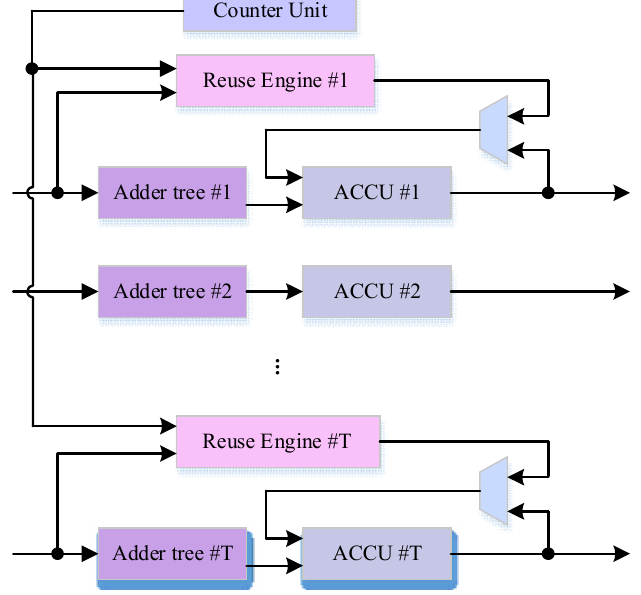
Figure 5. The architecture of Reusing Processing Module.